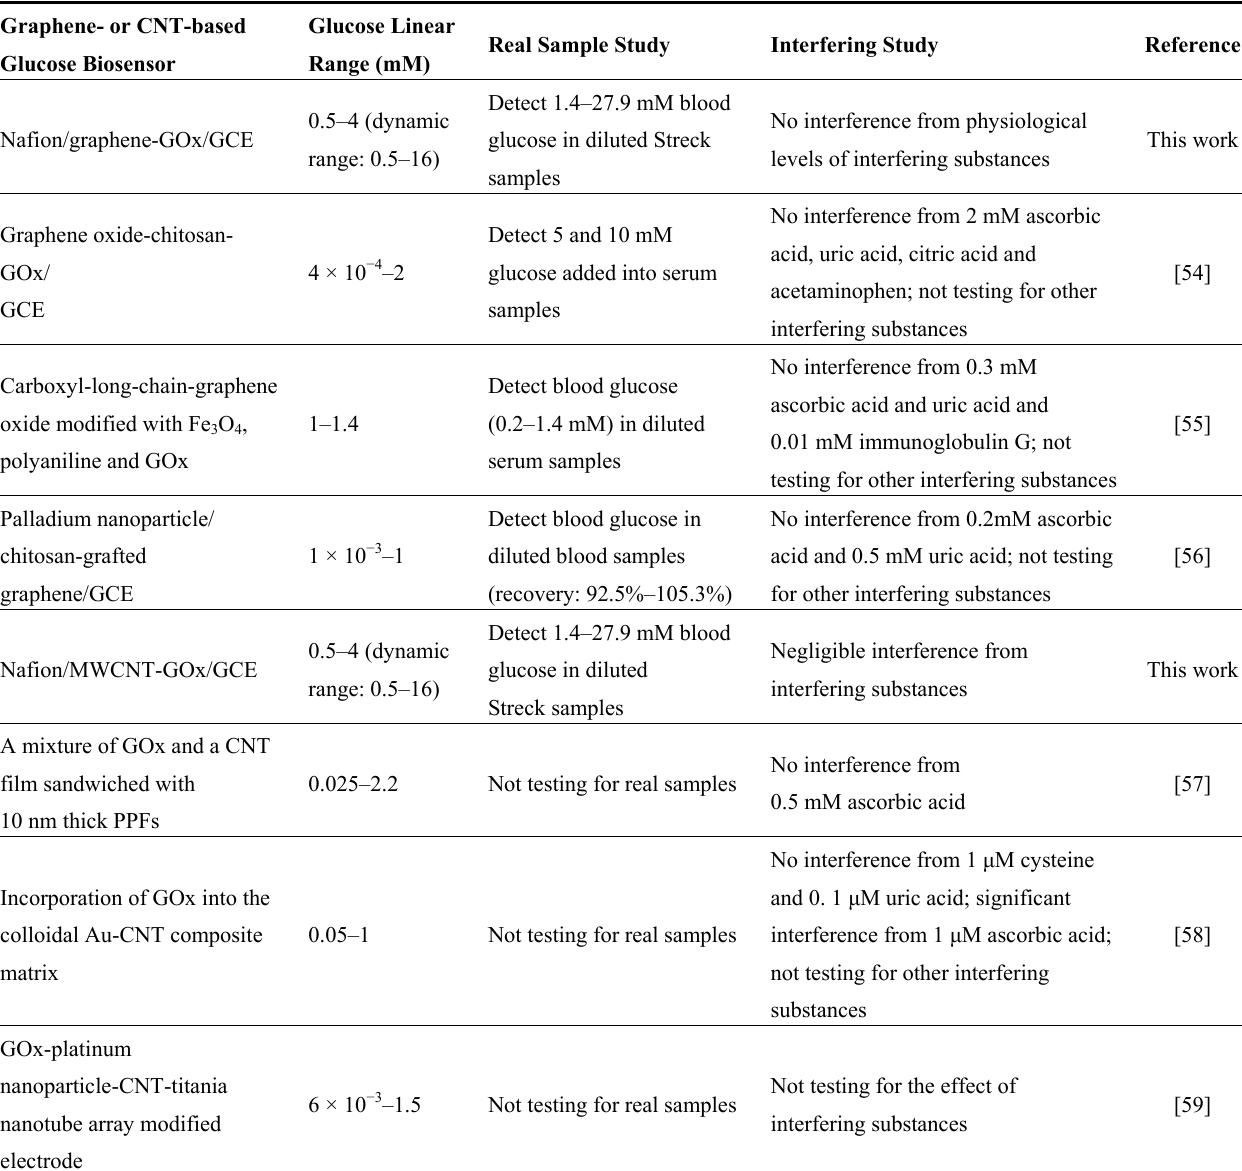
Table 1. Detailed comparison between this work and recently reported graphene- and CNT-based glucose